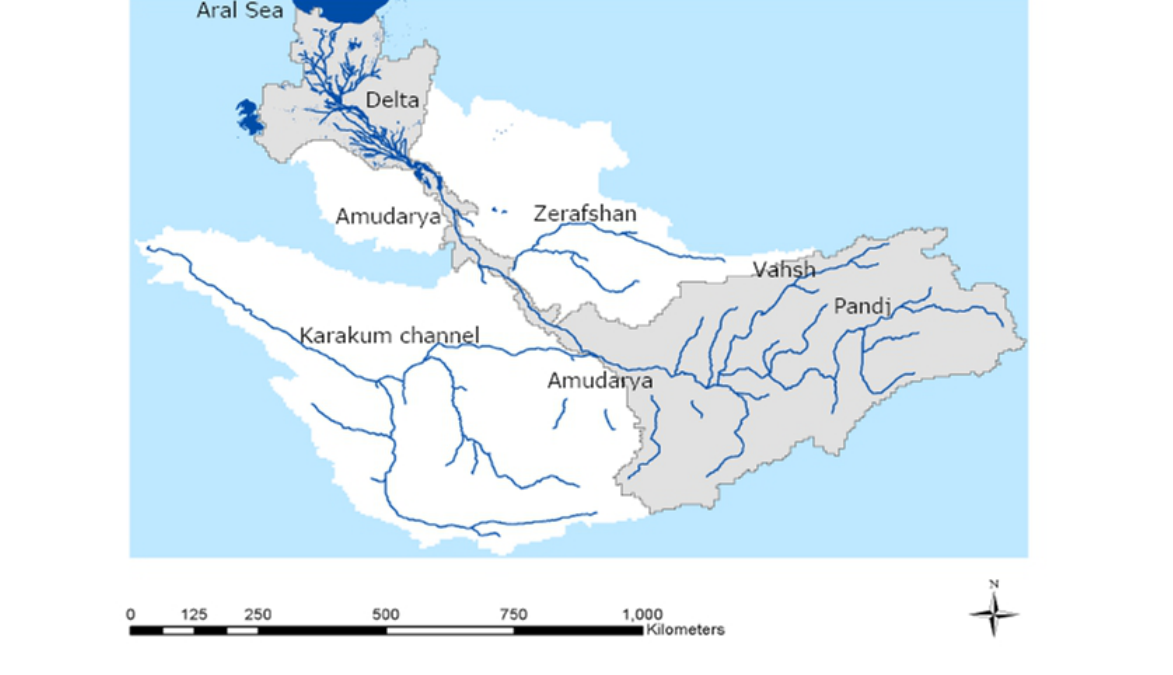
Fig. 1 . Map of the Amudarya River Basin. The grey shading indicates the catchment area of the Amudarya river (Siderius & Schoumans